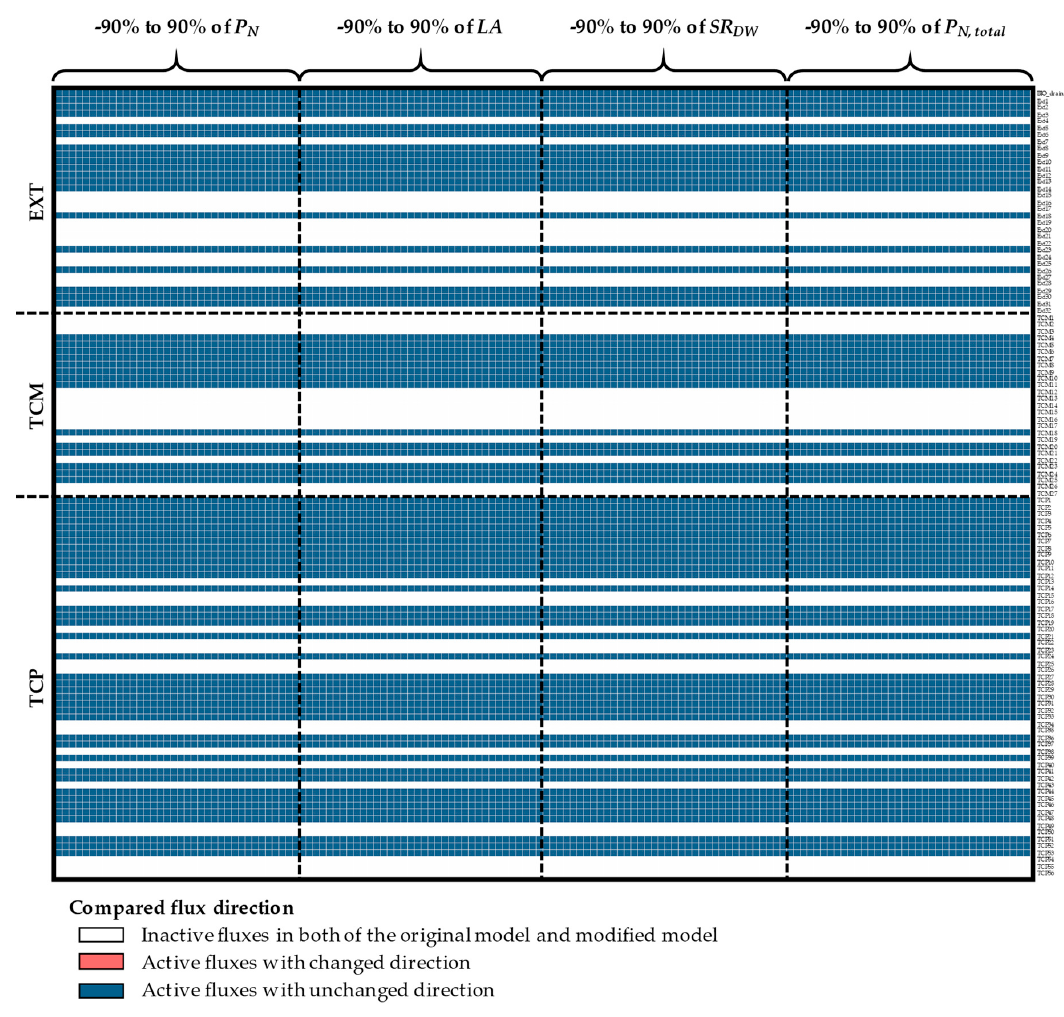
Figure A5. The sensitivity of the transport and exchange reaction flux direction to variations in the sucrose uptake rate-related data. Inactive reactions containing zero fluxes are denoted by white-colored grids. Active reactions, non-zero fluxes, with similar flux direction as the original model are denoted by blue grids; while those with dissimilar flux direction (breakpoint) are denoted by red grids. LA ; total leaf area per plant; P N , photosynthetic rate; P N, total , total photosynthetic rate per plant; SR DW , storage root dry weight per plant; EXC, exchange reaction; TCM, transport reaction between cytosol and mitochondria; TCP, transport reaction between cytosol and plastid.